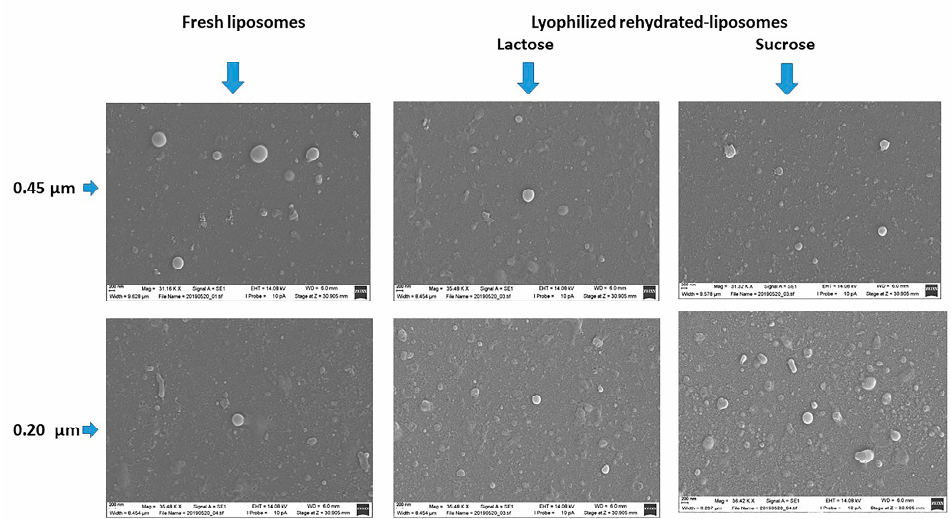
Figure 6. SEM images of fresh and rehydrated